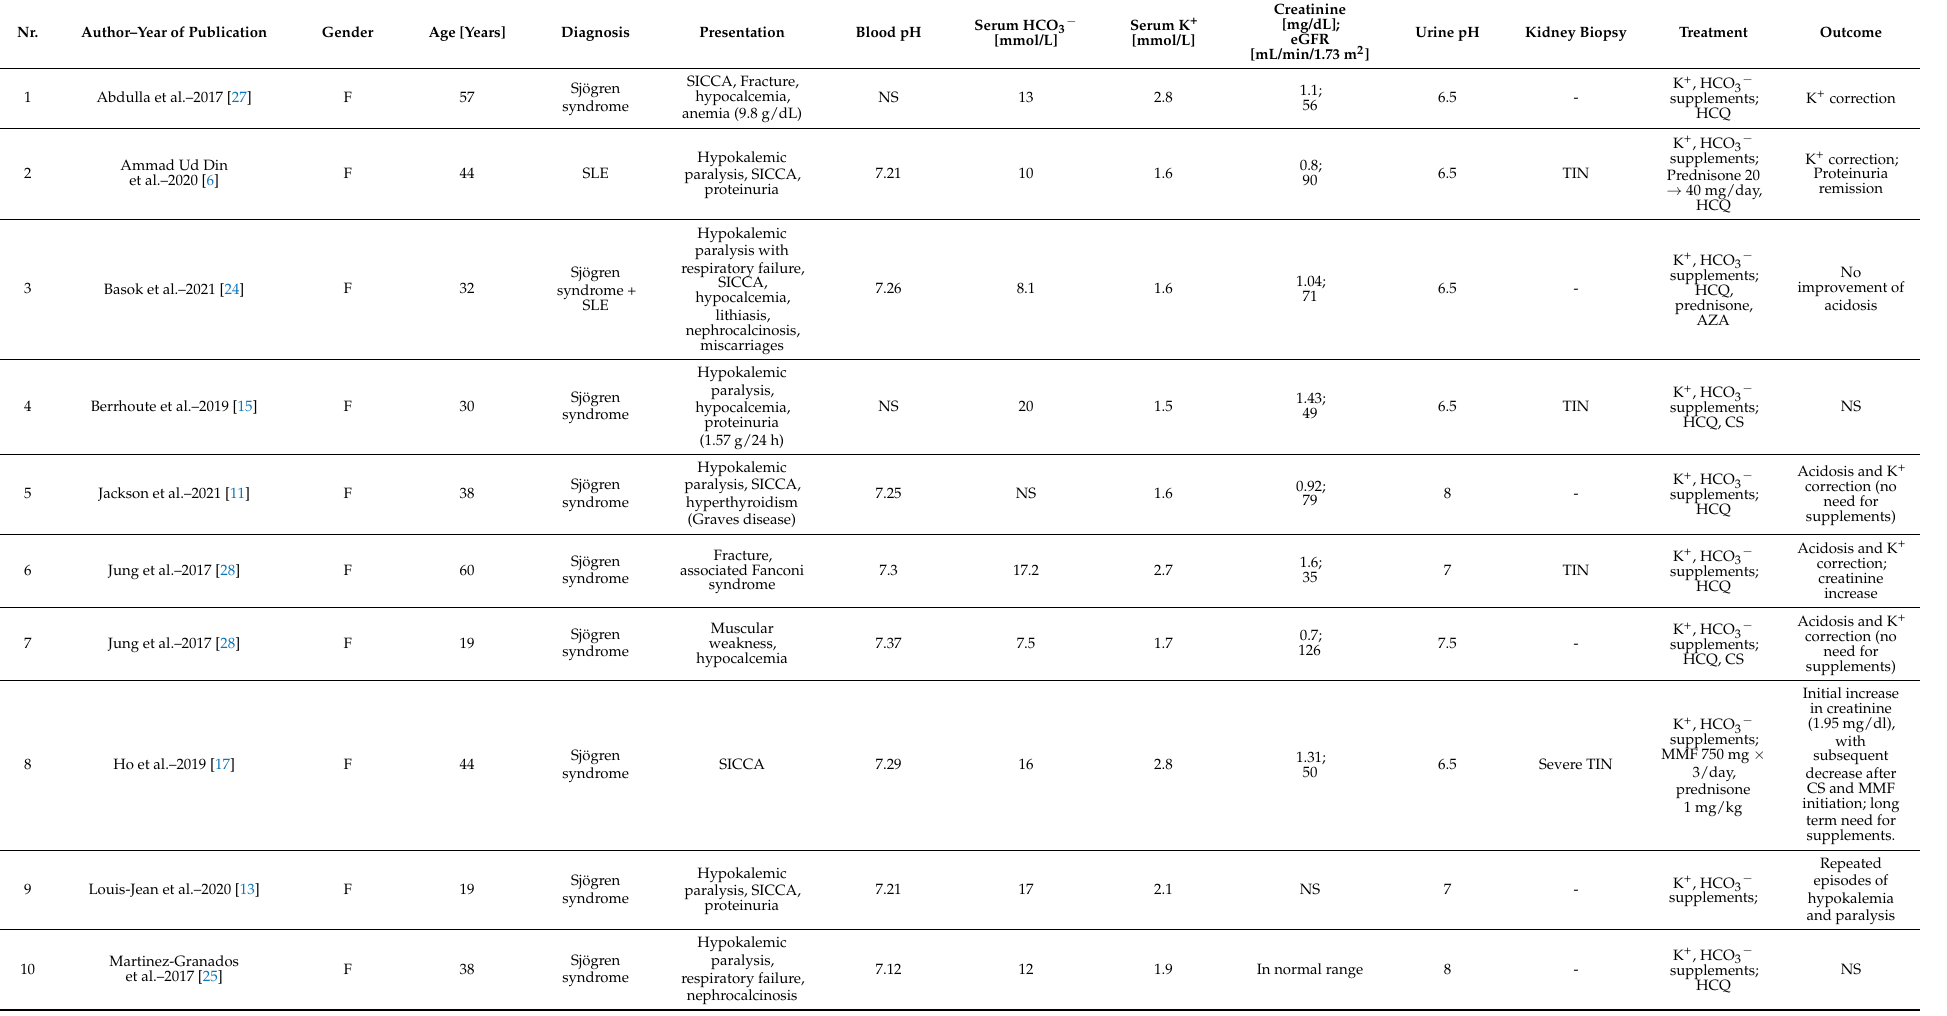
Table 1. Summary of recently published case reports, which describe the association of dRTA and autoimmune